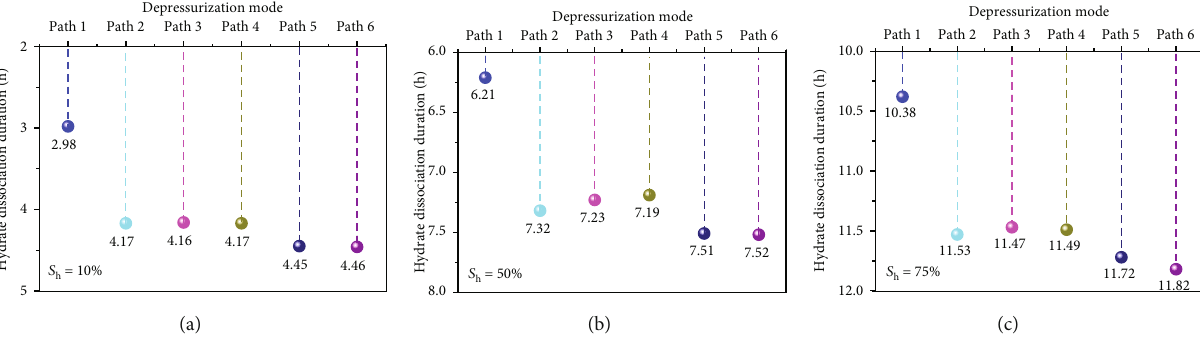
Figure 12: Hydrate dissociation varies with the depressurization mode under di ff erent hydrate saturations.